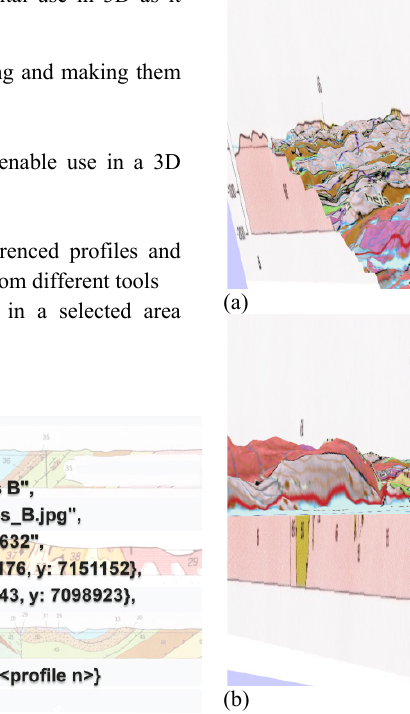
Figure 13: JSON code of implementing of visualisation of profile- Namsos B, (Nord-Trøndelag, Figure 15: A geological profile projected into 3D space: (a) the Norway). view from above (top), (b) the view under the surface